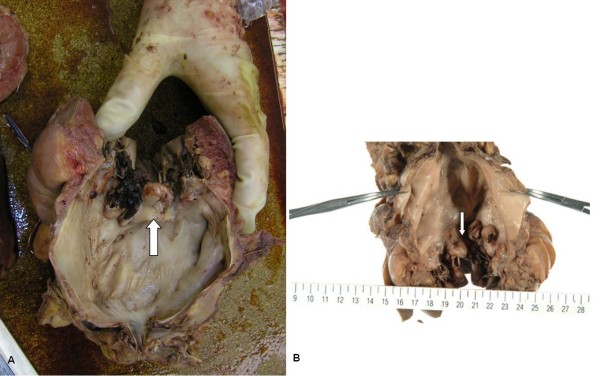
A rigid node on the mitral valve (arrow), found during autopsy (A, B).